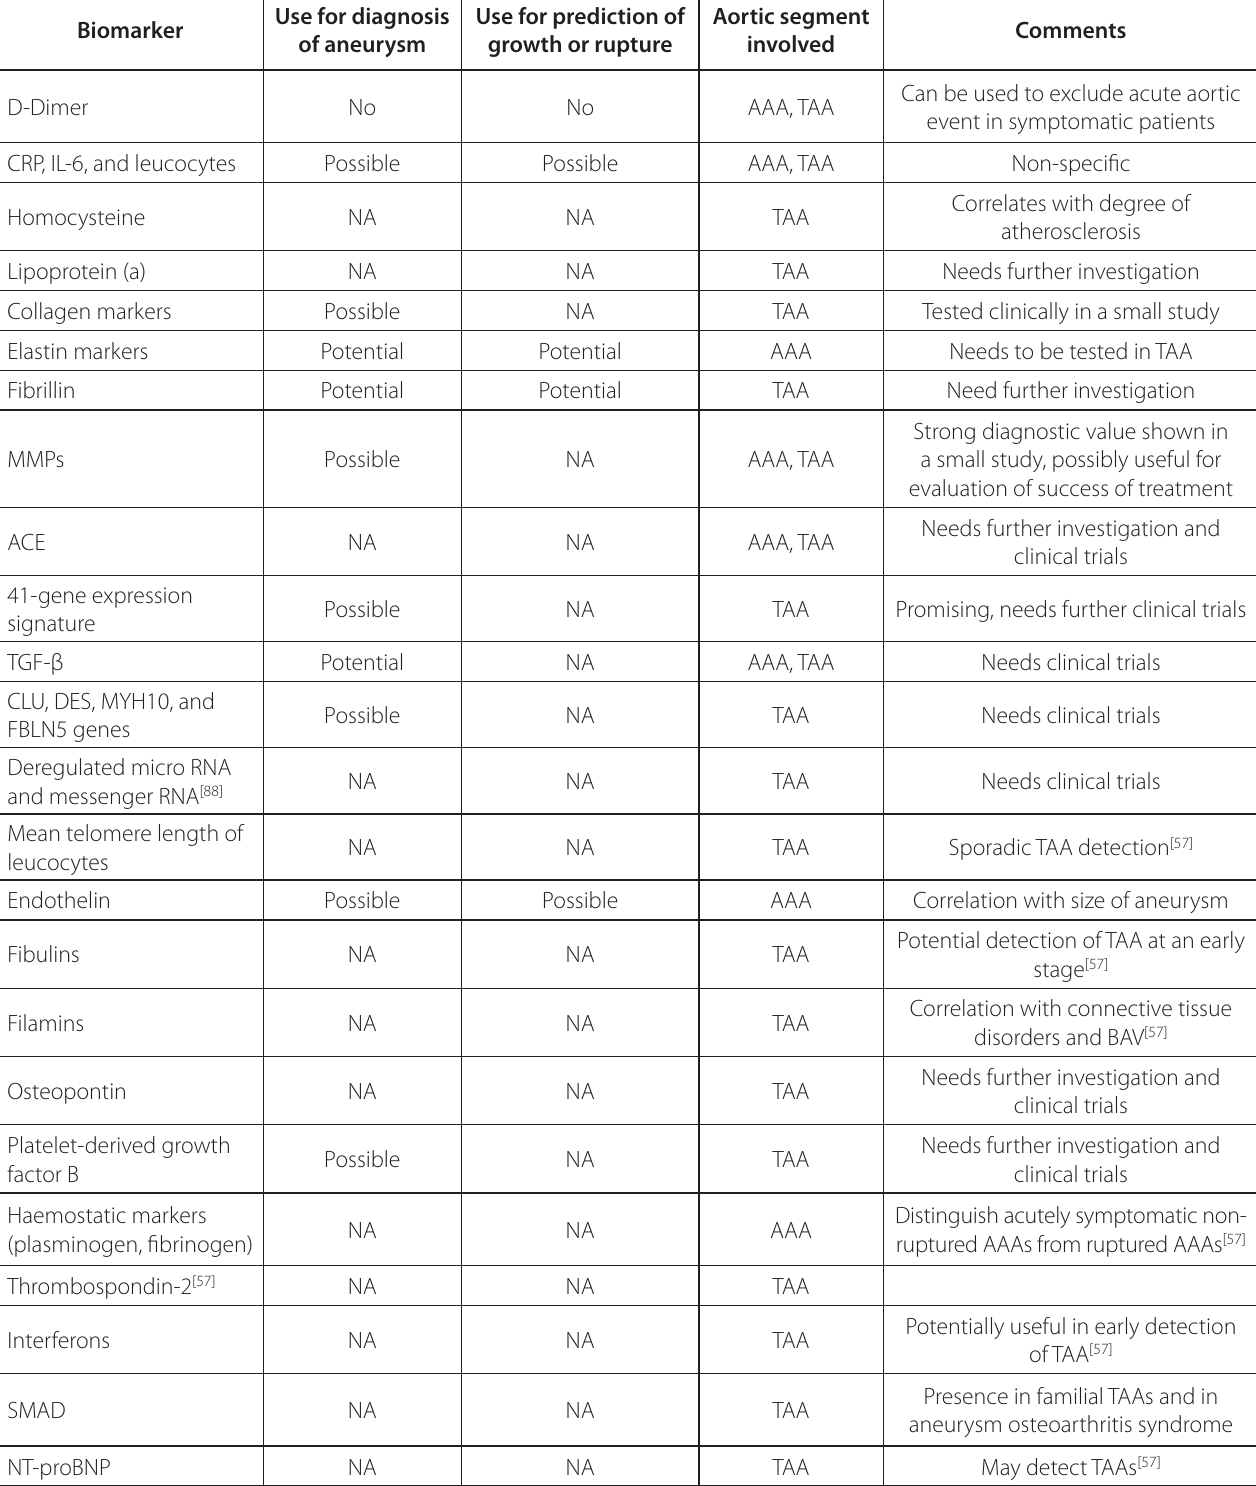
Table 6 . Potential TAA